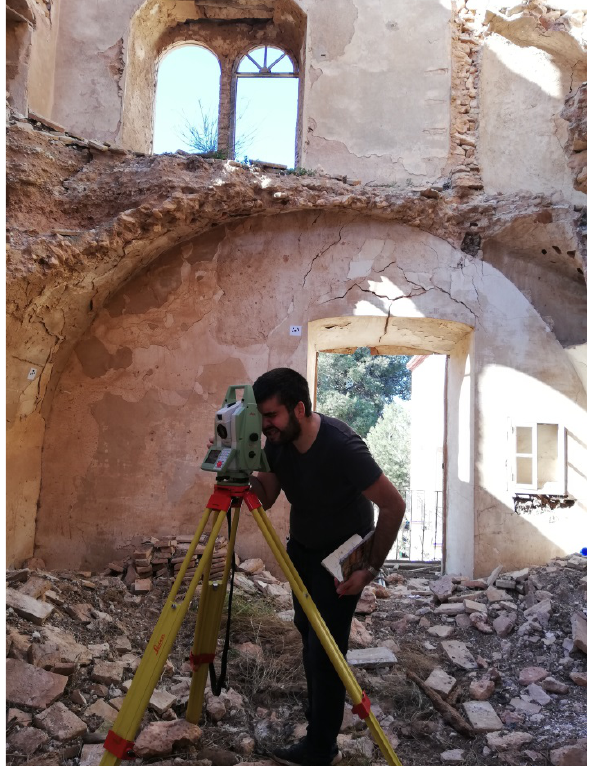
Figure 4. View from above of the stations points connected by classical topography together with the red line and the control points used, measured in the Negro tower.